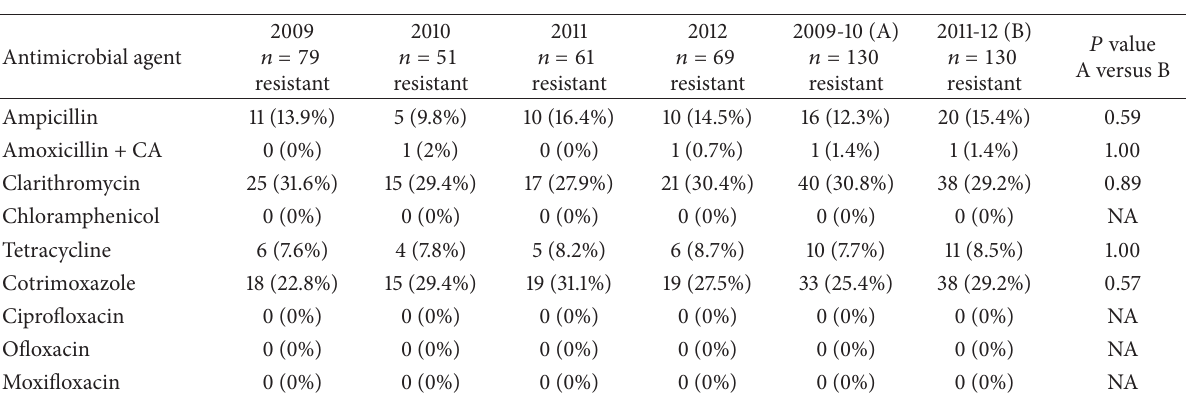
Table 5: Trends in antibiotic resistance of H. influenzae and M. catarrhalis isolates. (a) Haemophilus